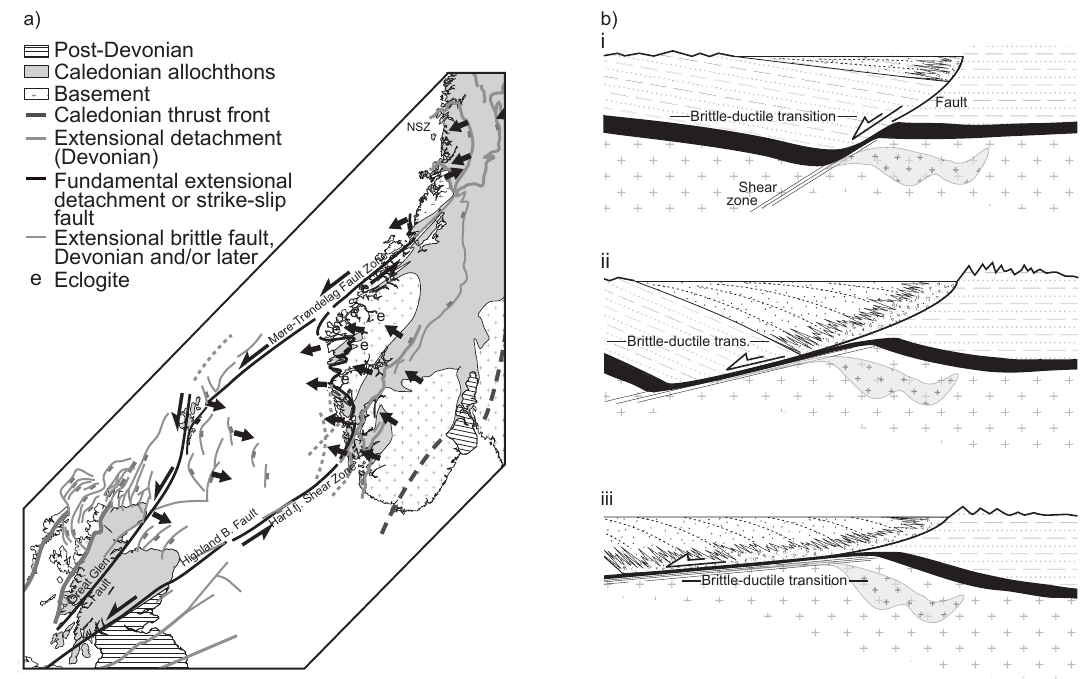
Fig. 7. Figures modified from Fossen (2010) showing the suggested role of transtension in the exhumation of the Caledonian ultra-high- pressure Western Gneiss Region in Norway. (a) Sketch structural map of western Norway and Scotland showing the major strike-slip and detachment faults, gross geology and location of major eclogite bodies. (b) Illustration of how low-angle detachments may form initially as high-angle faults that rotate to lower angles at increasing strain. This allows rotating beds to develop in hanging-wall basins, such as the Devonian Hornelen